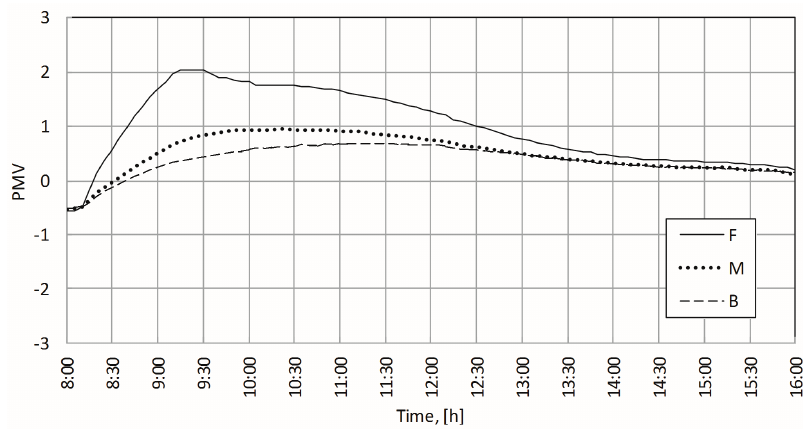
Figure 10. PMV in the analyzed o ffi ce during working hours. Figure 10. PMV in the analyzed office during working hours. Figure 10. PMV in the analyzed office during working hours. Figure 10. PMV in the analyzed office during working hours.